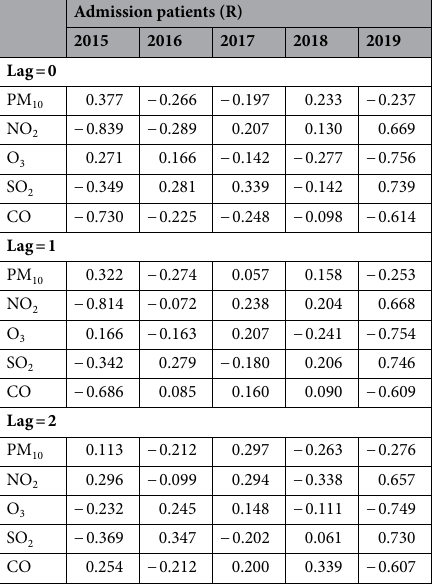
Table 4. Correlation between CD hospital admission and annual concentration of indicator